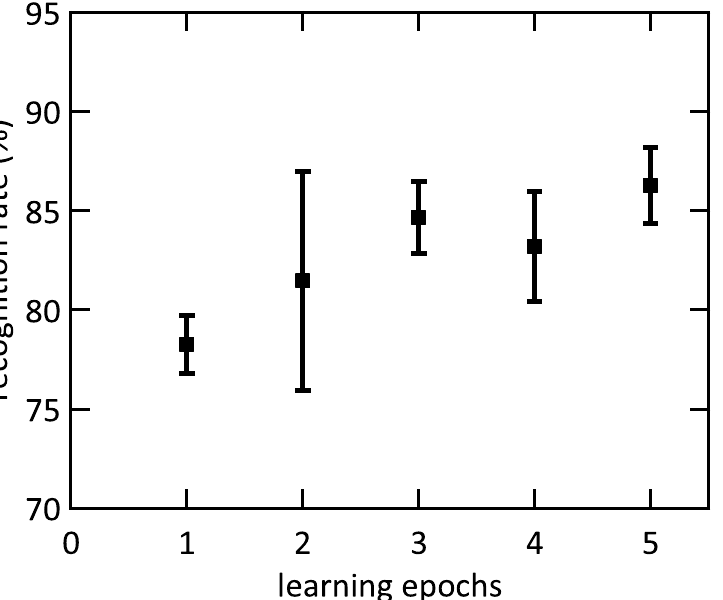
Figure 6. Convergence of the recognition rate. The patterns {0, 3, 8} were learned using the set transition of the polycrystalline devices. The mean values and standard deviations of 5 learning runs are depicted for each data